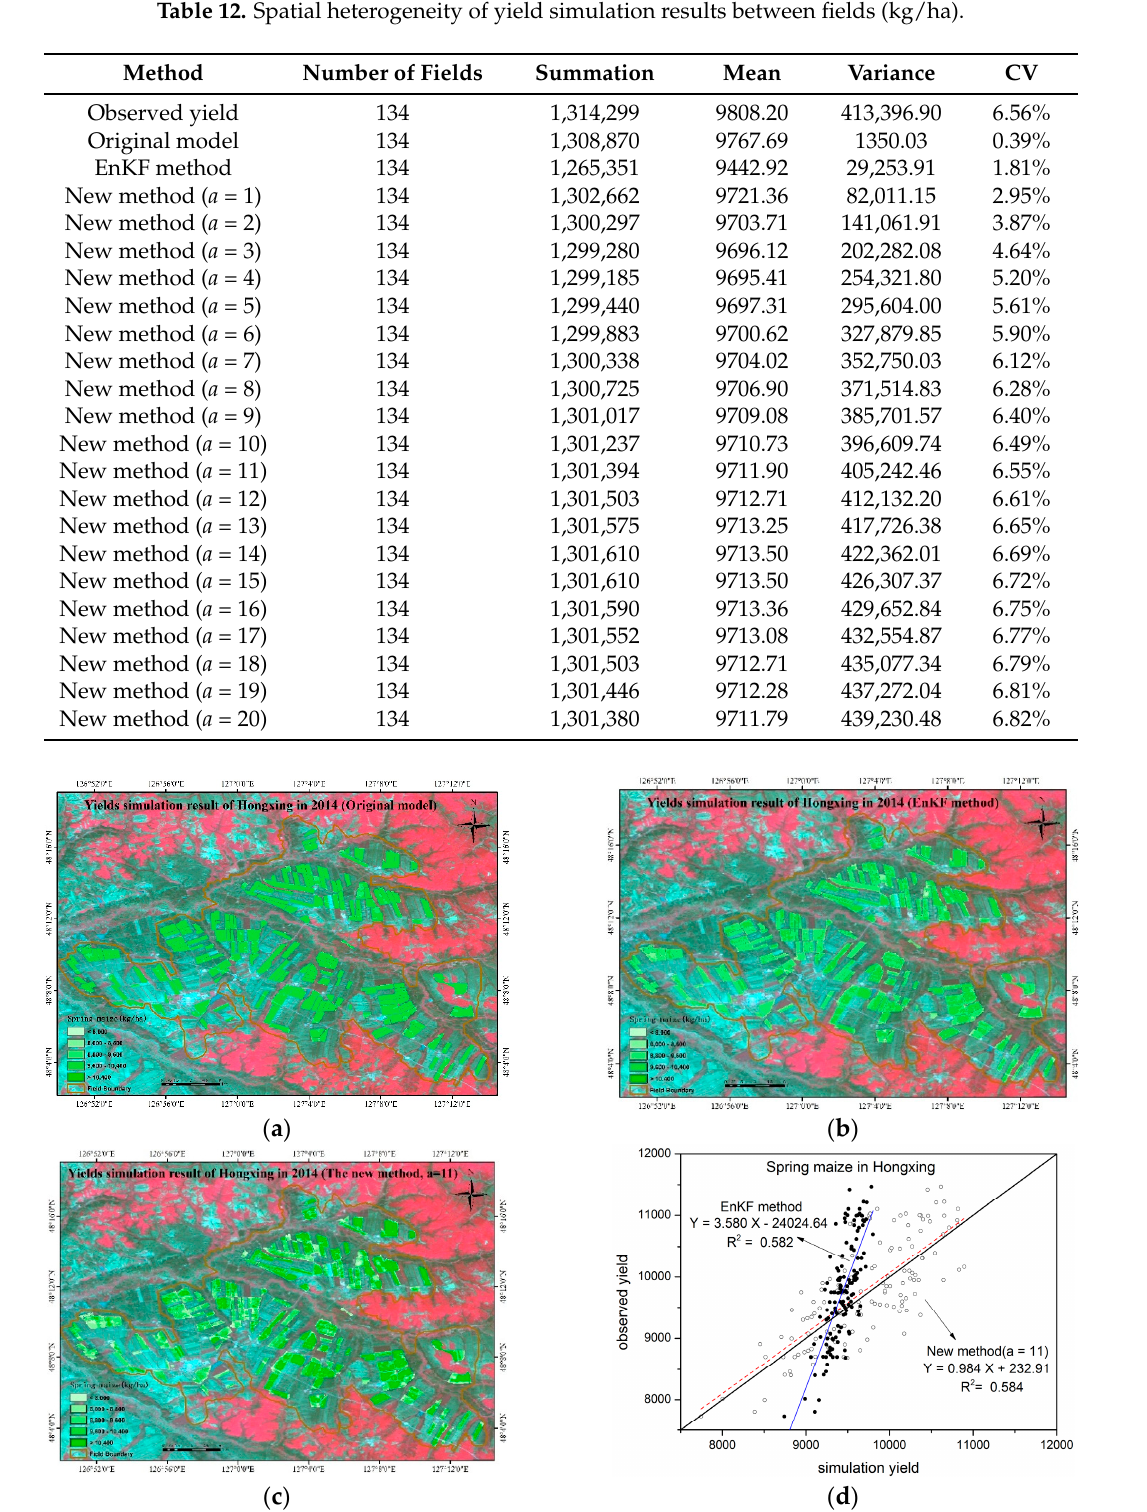
Table 12. Spatial heterogeneity of yield simulation results between fields (kg/ha).